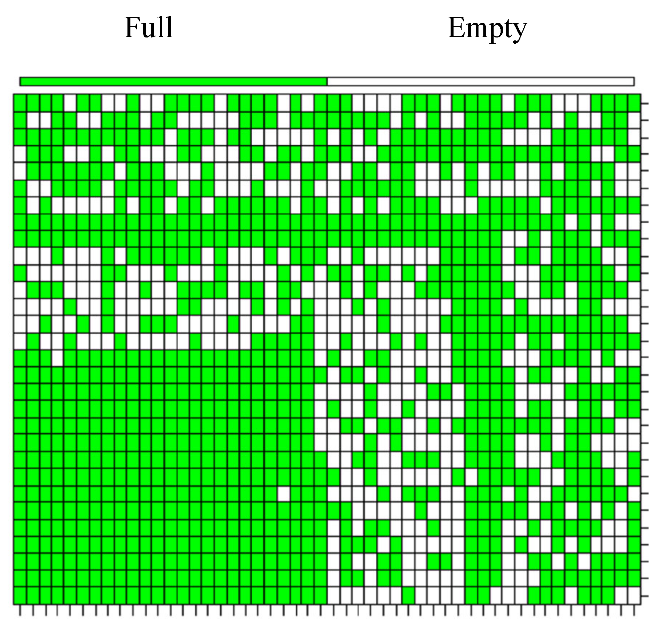
Figure 6. Final storage locations of method 1.